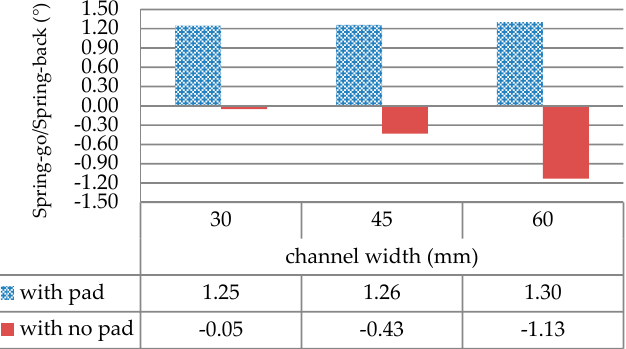
Figure 5. Comparison of the predicted spring-back/spring-go in cases of U-bending, with and without pressure pads, with respect to channel widths ( θ : 90°, R p : 7 mm, t : 3 mm, WP L : 120 mm, R ud : 5 mm).